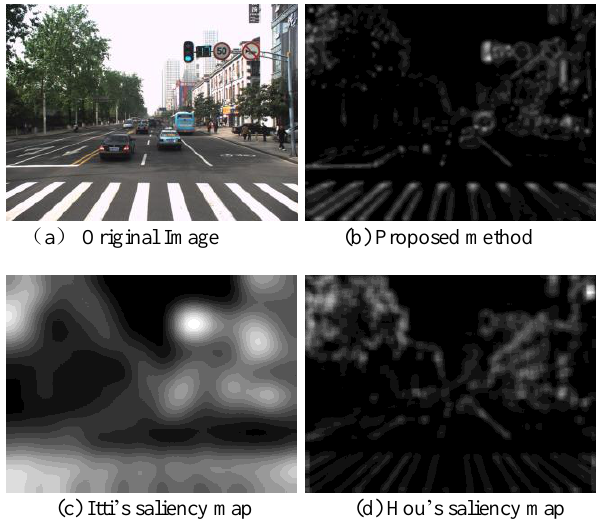
Fig.5. The results of different saliency method China's current standard is GB5768-1999 after revised in 1999 and mainly consists of warning signs, prohibition signs, indication signs etc. Because of their direct relationship with traffic safety, these three kinds of signs are the major studied objects. This research aims to prohibition signs, but partial indication signs. are also round, so this method is also able to detect partial indication signs. 1) Image down-sampling Firstly, the size of images is 640*480. The length side is more than 640 pixels, which should be resized to be 640 pixels. To illustrate the proposed detection method is effective, image keeps the original complexity without any cut. 2) Target Segmentation After down-sampling, images were segmented by using the process shown in Fig.